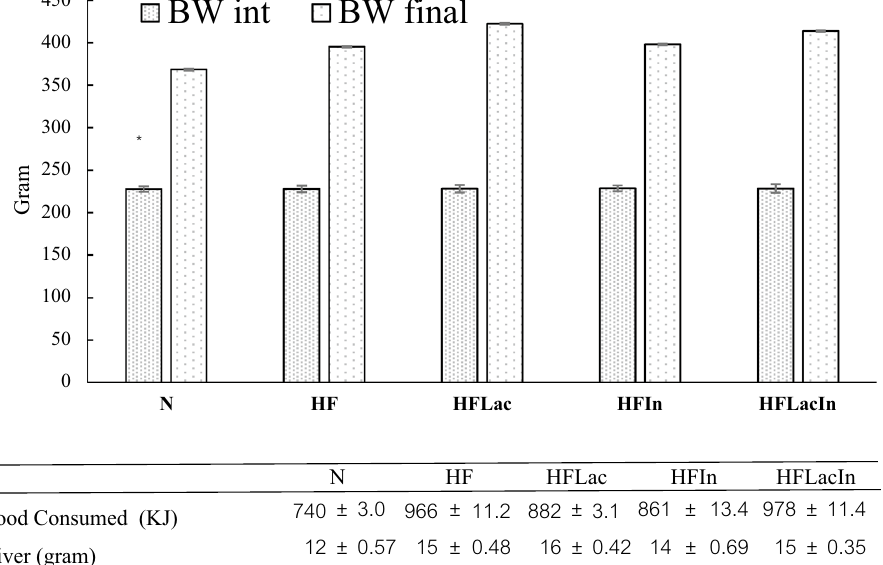
Figure 1. Body mass (g), food consumption (KJ/day), and liver mass (g) of the rats in each group (n = 13). (N) Rat fed a normal diet (HF) Rats fed with a high fat diet (HFLac, HFIn, HFLacIn,) Rats fed with a high fat diet and L. acidophilus , inulin, and L. acidophilus + inulin,